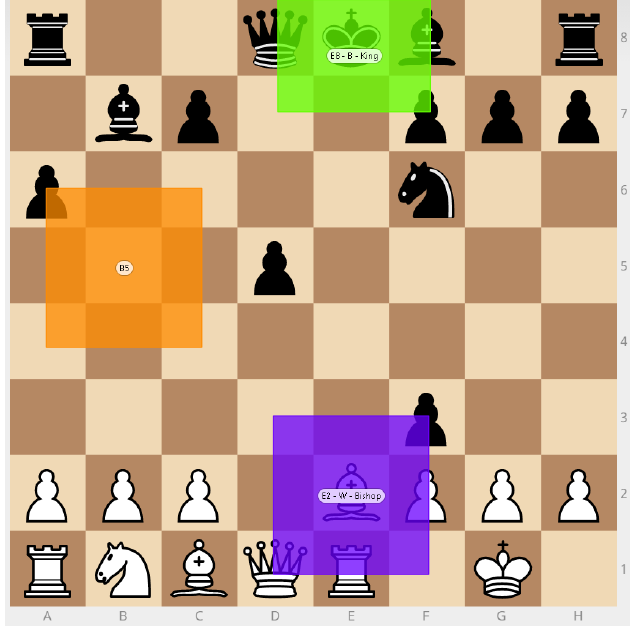
Figure 3. Three Areas Of Interests (AOIs) are centered around 2 key pieces and one square where a piece has to be